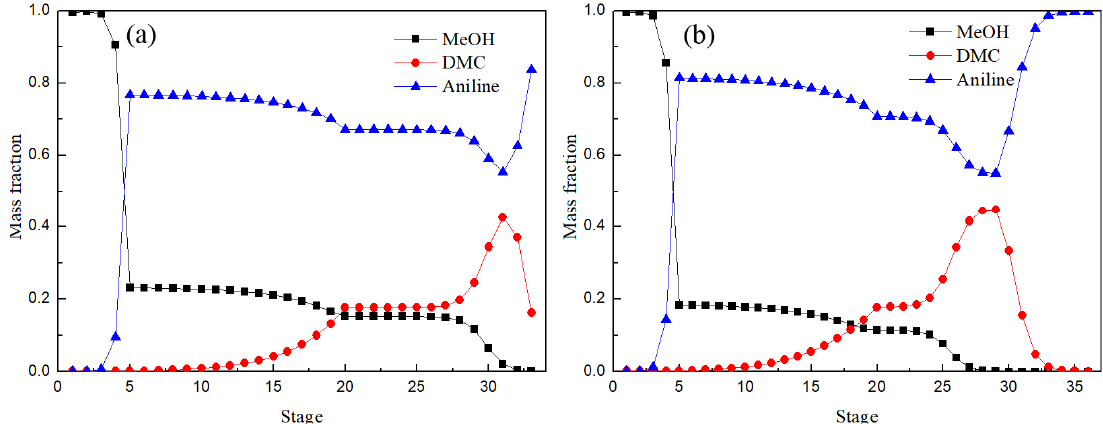
Figure 12. Liquid composition profiles of EDC ( a ) and main column of EDWC ( b ).